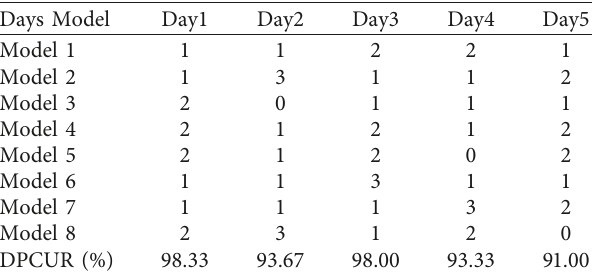
Table 5: Random order sequence of prefabricated walls of